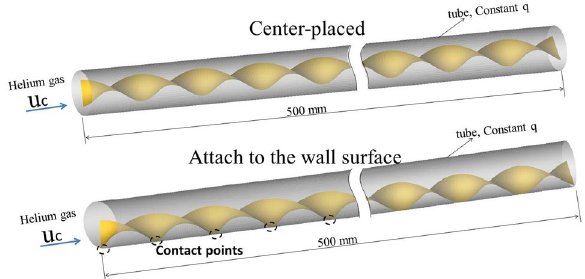
Figure 1. A schematic diagram for the tube with center-placed and attach to wall surface twisted tape (W = 12 mm).